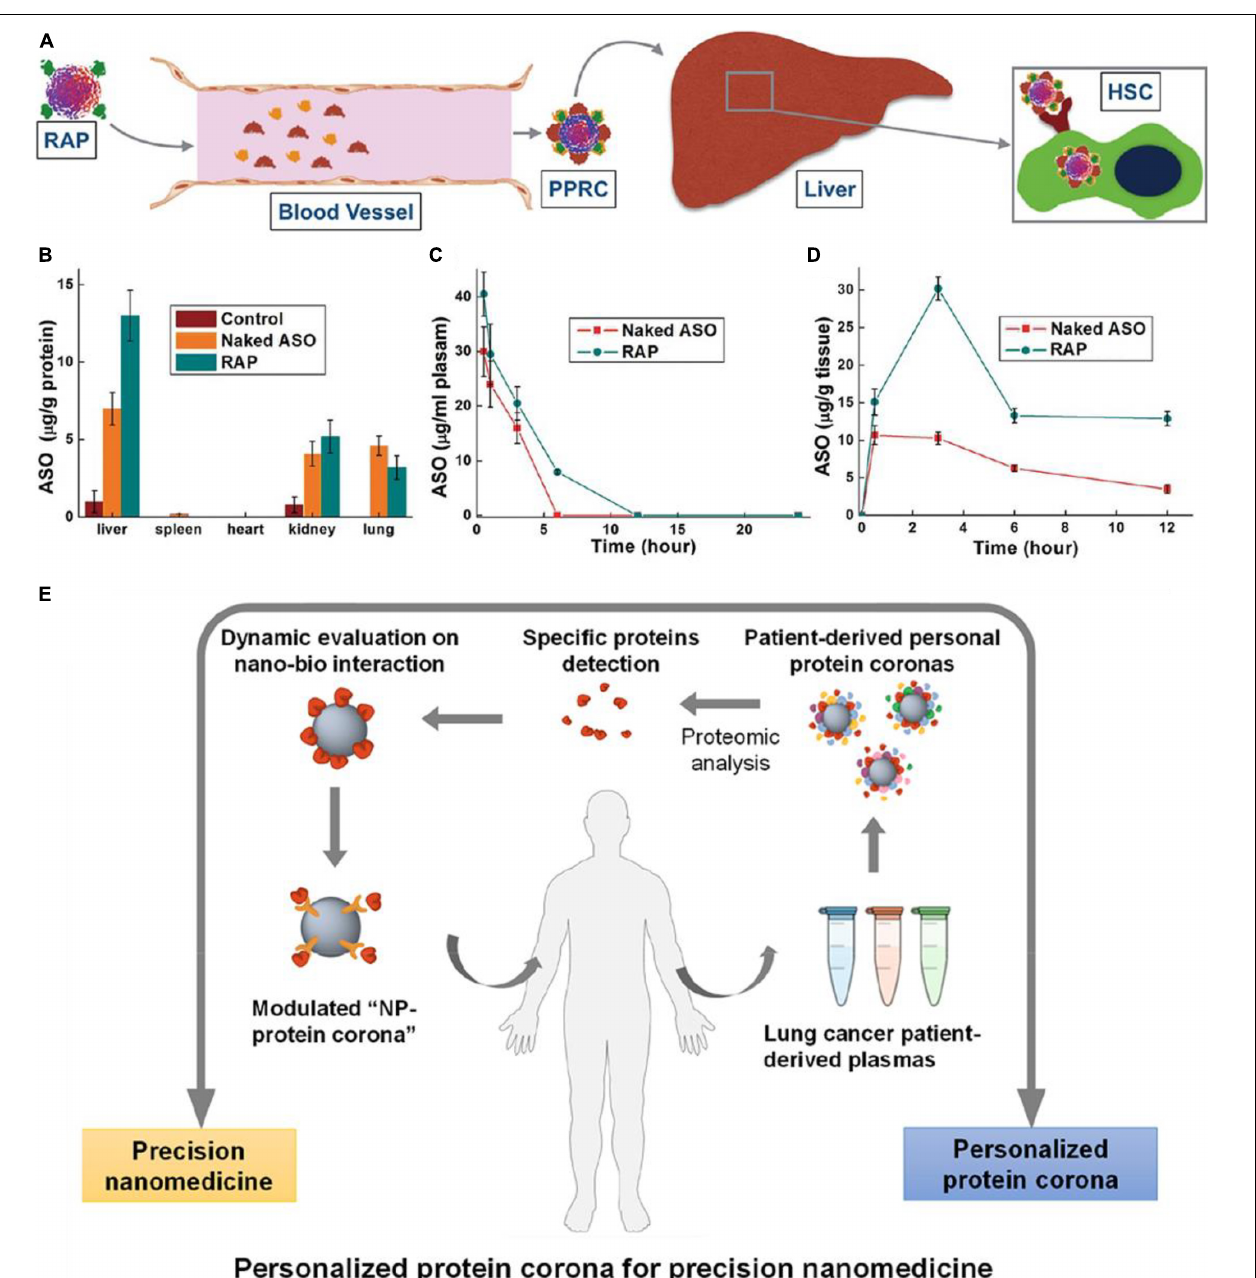
FIGURE 4 | Sample applications of in vivo PC formation in nanomedicine. (A) Schematic diagram showing the fate of ASO-loaded retinol-conjugated polyetherimine (RAP) NPs after intravenous administered. (B) ASO (naked or delivered by RAP NPs) distribution in different organs. (C,D) Time-dependent ASO (naked or delivered by RAP NPs) concentrations in (C) the blood and (D) the liver. Adapted with permission from Zhang et al. (2015). (E) Schematic illustration of nanomedicine development strategy based on systematic analysis of patient-personalized PCs. Adapted with permission from Ren et al. (2019).